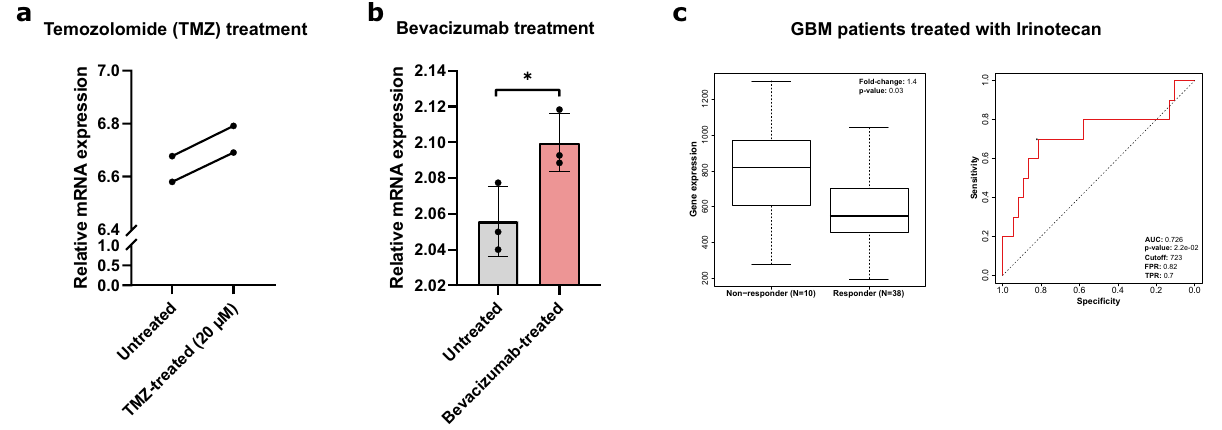
Figure 8. GPX7 expression in glioma models treated with chemotherapy. ( a ) The relative GPX7 mRNA expression of human glioblastoma cell line (U87MG) treated with temozolomide at 20 µM for 24 h (GDS4808 from GSE43452 dataset) 36 . Two-tailed Wilcoxon rank-sum test was used ( p -value = 0.0106); ( b ) Relative GPX7 mRNA expression in U87MG-EV human glioblastoma xenograft tumor treated with bevacizumab (10 mg/ kg body weight) (GDS5672 from GSE39223 dataset) 37 . Results are shown as mean ± SD. Statistical significance is denoted by *** p < 0.001 compared with control. ** p < 0.01 compared with control. * p < 0.05 compared with control; ( c ) Box plot (left) depicting the expression of GPX7 (probe 213170_at) in GBM patients annotated with chemotherapy responses according to the Response Evaluation Criteria in Solid Tumors (RECIST) criteria. Graphs show normalized gene expression in irinotecan non-responders and responders patients. ROC plot of non-responders (N = 10) and responders (N = 23) of GBM patients treated with Irinotecan based on overall survival (OS) at 16 months. Error bar ± SD. AUC: area under the curve. PPV, positive predictive value; TPR: true positive rate.